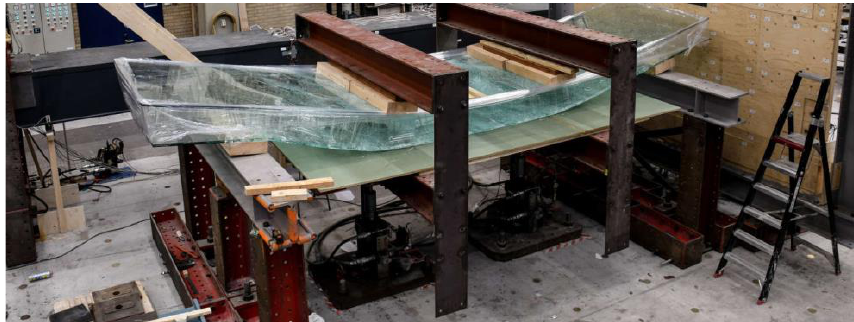
Fig. 18 Side view of test after first loading sequence.